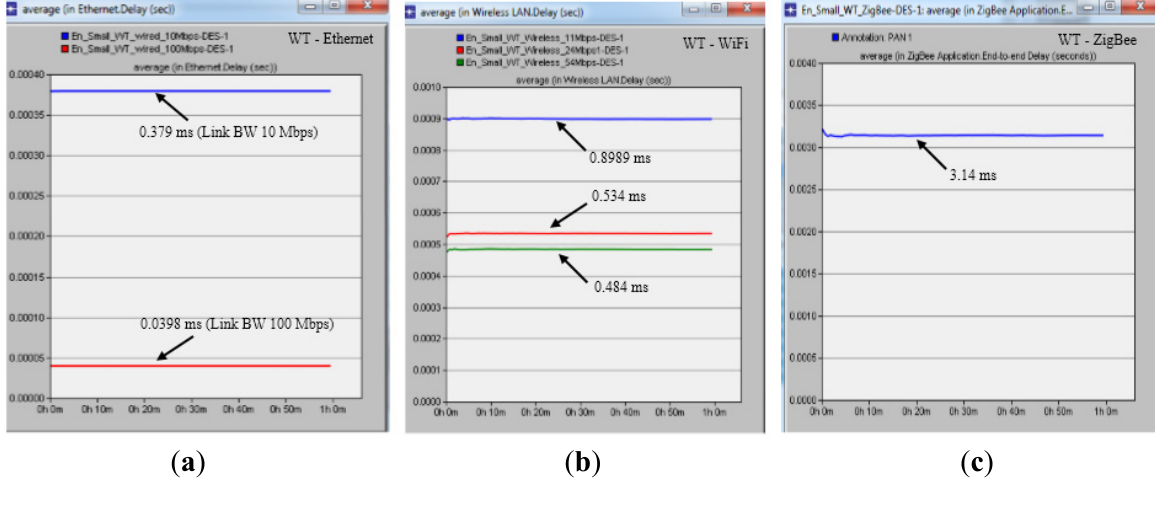
Figure 9. Average ETE delay for a small-scale WT. ( a ) Ethernet-based architecture; ( b ) WiFi-based architecture; ( c ) ZigBee-based